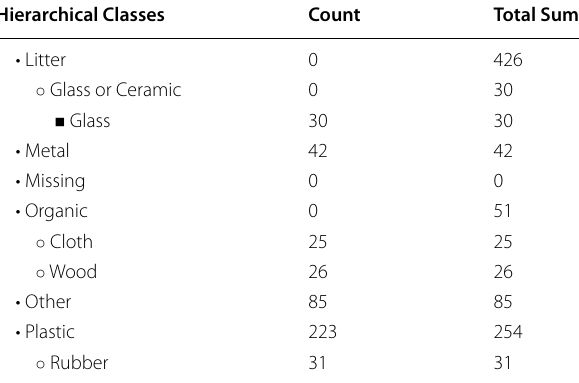
Table 1 Example of lumping analysis for SMC material classes with the NOAA material classes. Both data cards are first joined to the materials alias relational table, then to the hierarchical table. The final result can be plotted to show how a joined survey list could be lumped. The tree structure under Hierarchical Classes is tabbed to show finer levels of granularity in the descriptions. Count is the number of objects of that material type that the surveys observed. Total Sum is how those sums would lump given the hierarchy. The class Missing is the number of classes that were not integrated into the TTT. Zero indicates an